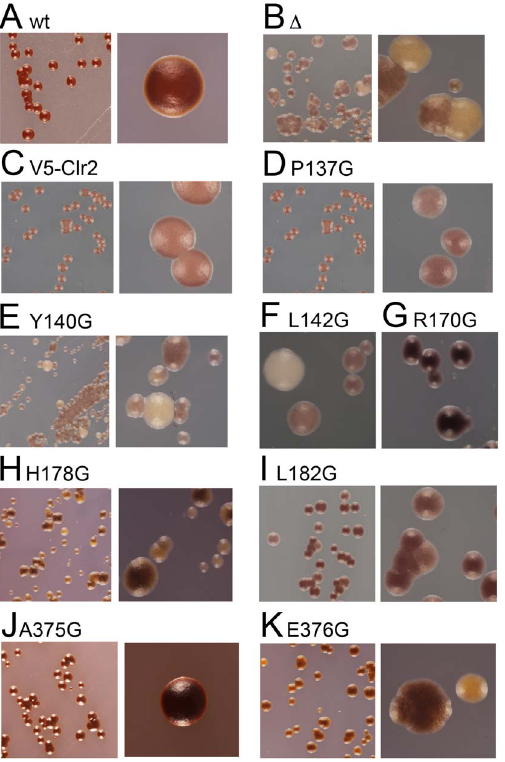
Figure 4. Strains containing point mutations in Clr2 has mottled and sectored iodine stained yeast colonies. (A) PJ1044, the wild-type strain (Clr2), (B) PJ1085, lacking Clr2 ( D ), (C) PJ1335 contains the V5-Clr2, (D) PJ1349 with V5-Clr2P137G, (E) PJ1425 with V5-Clr2Y140G, (F) PJ1424 with V5-Clr2L142G, (G) PJ1347 with V5- Clr2R170G, (H) PJ1361 with V5-Clr2H178G, (I) PJ1362 with V5-Clr2L182G, (J) PJ1363 with V5-Clr2A375G and (K) PJ1353 V5-Clr2E376G.